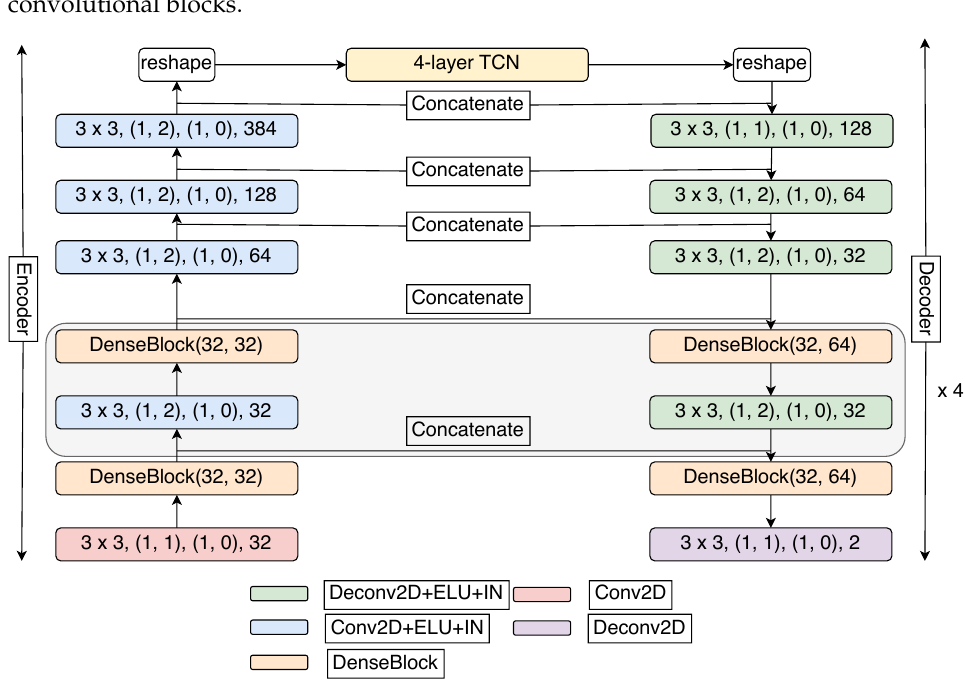
Figure 2. The diagram of